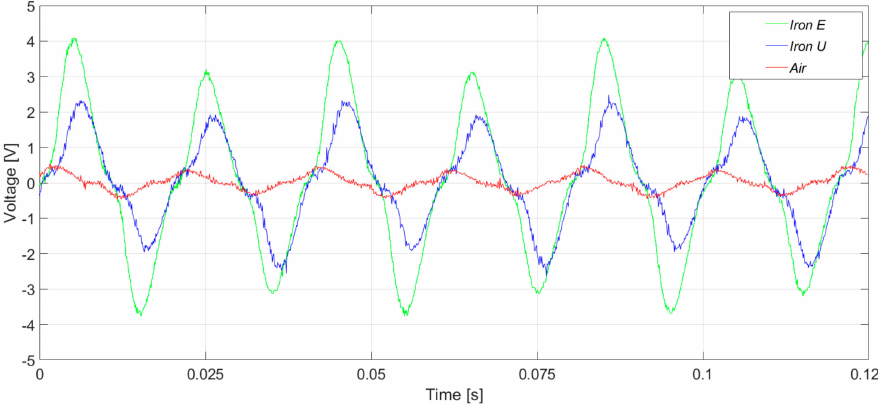
Figure 11. Induced voltage measurement with a 5% inter-turn rotor fault severity, in the upside position.